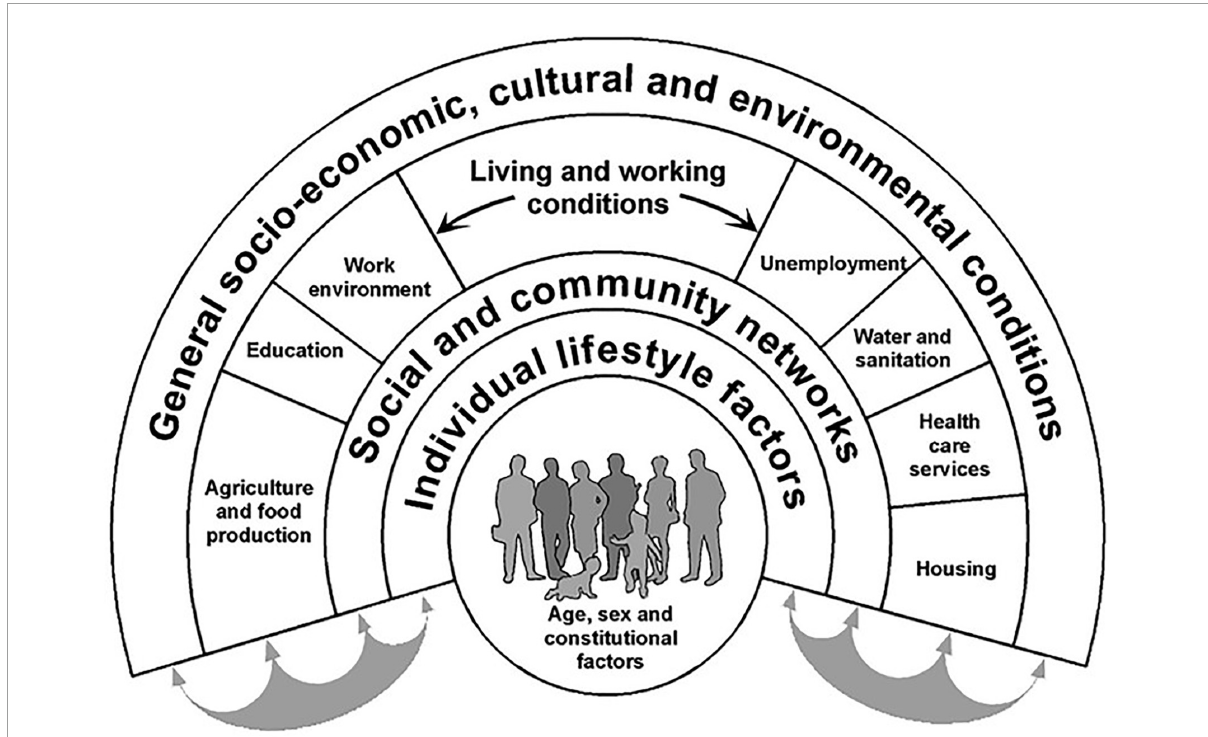
FIGURE2 Dahlgren–Whitehead model of health determinants [from: (178), p. 22, (180), p. 36]. Source: adapted from Dahlgren and Whitehead